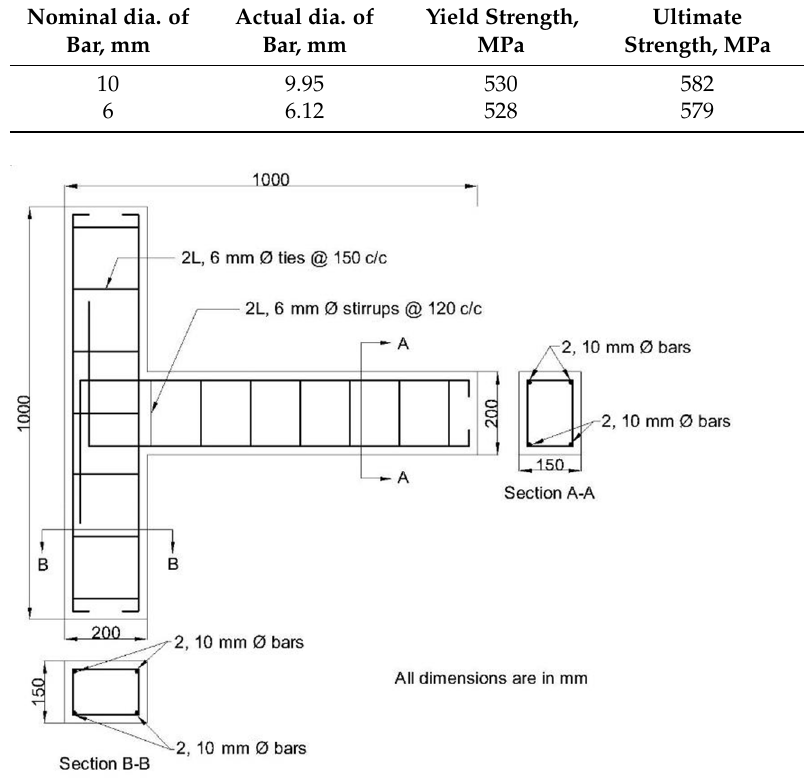
Figure 2. Details of the beam-column joint. Table 2. Properties of reinforcing bars.